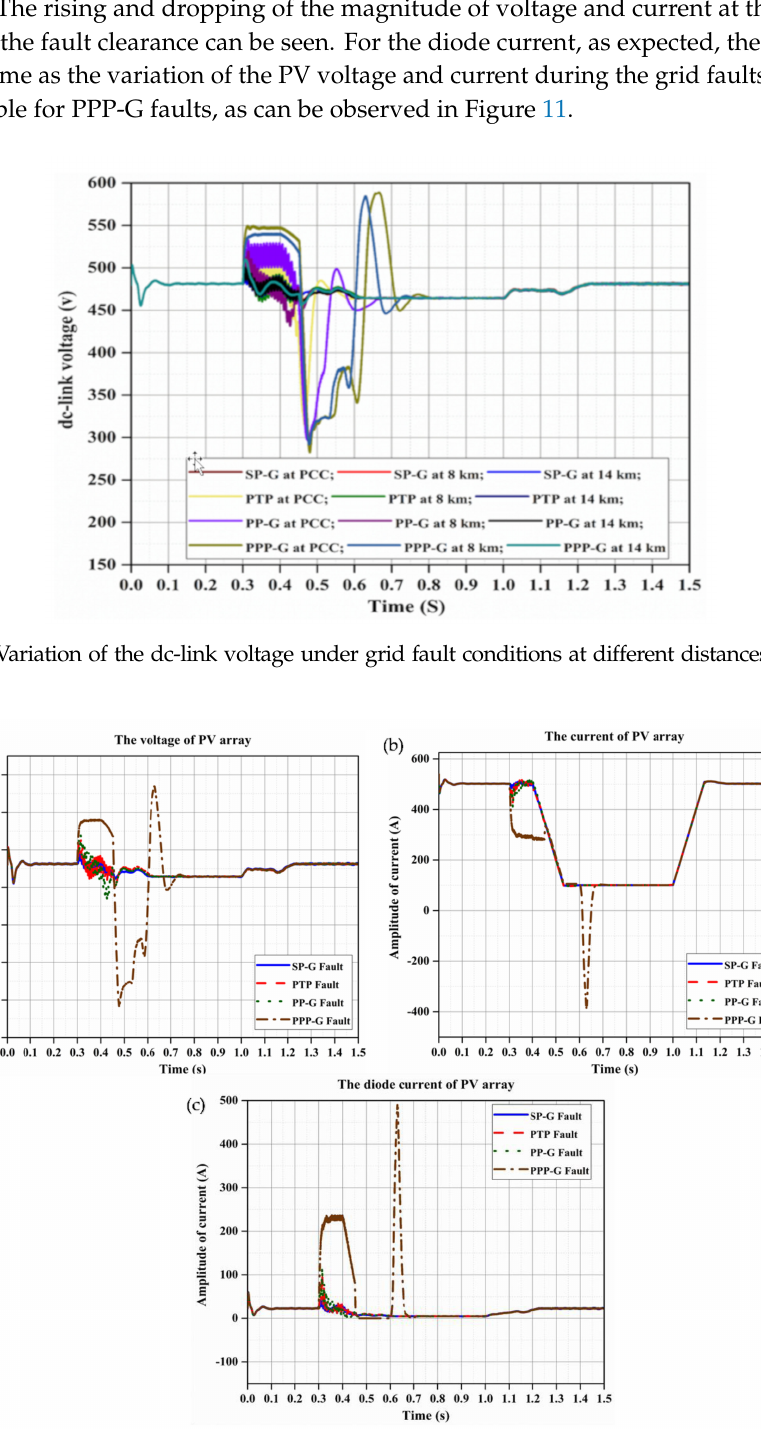
Figure 11. ( a ) The output photovoltaic (PV) voltage; ( b ) the output PV current; ( c ) the PV diode current under grid fault conditions 8 km away from the